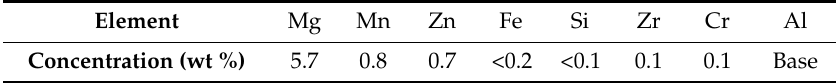
Table 1. Chemical composition of the studied alloy. Element Mg